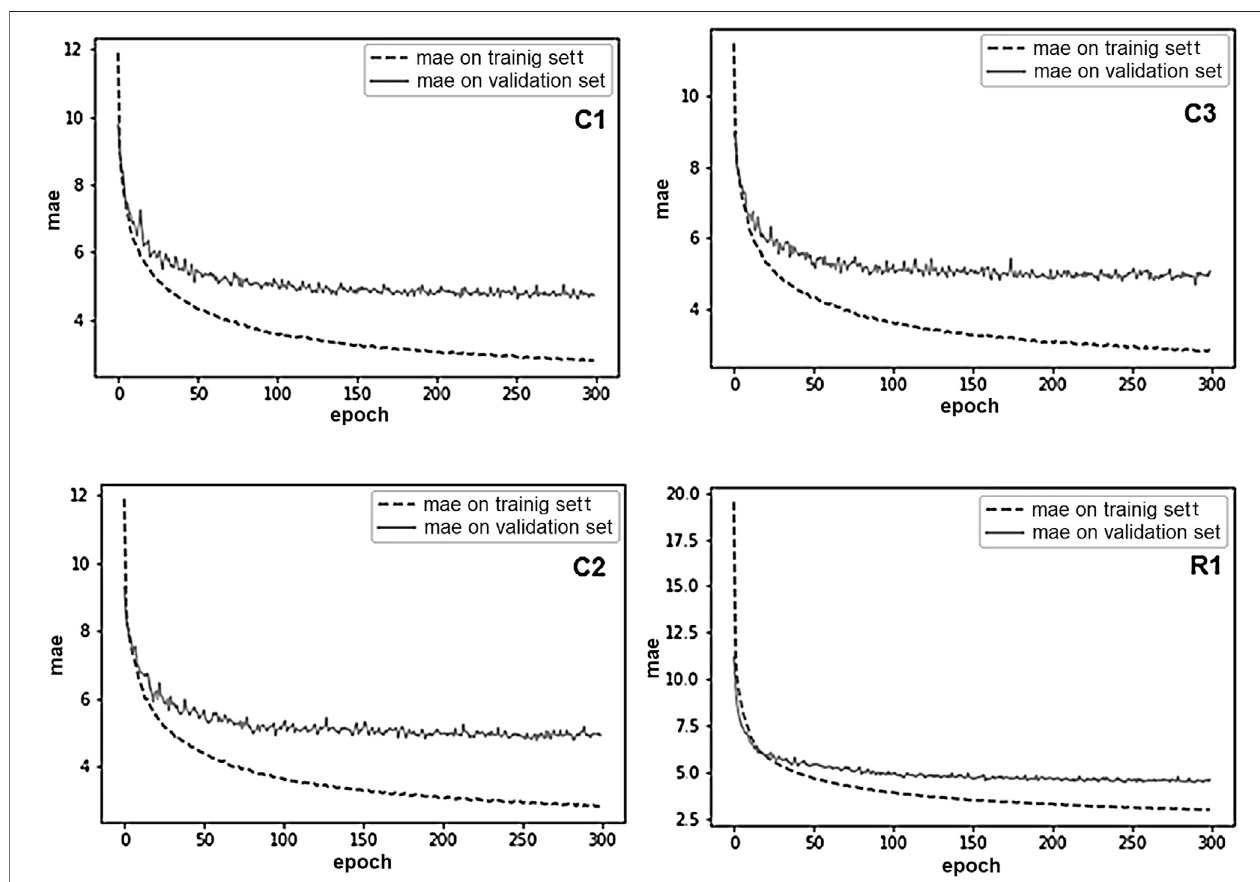
FIGURE 7 | Architecture of final ensemble of neural networks.